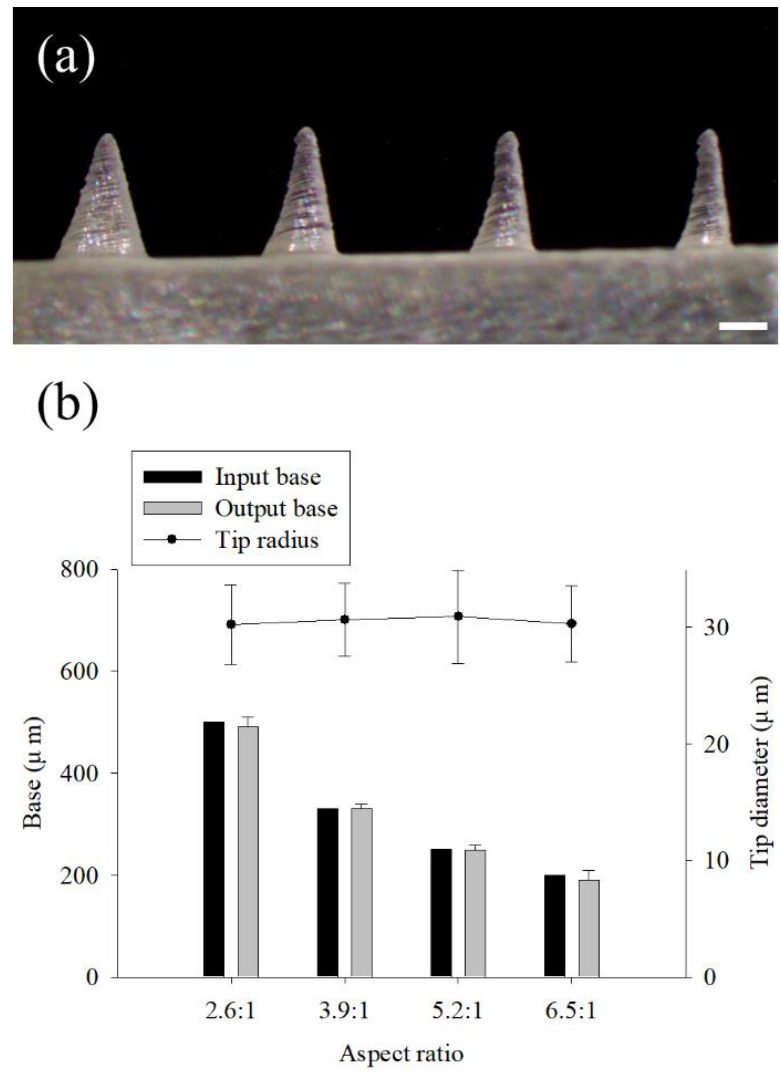
Figure 3. Effect of the aspect ratios of the microneedle on the 3D printing. Stereomicroscopic images of the microneedles with 1300 µ m input height and 500 µ m base at the aspect ratios of 2.6:1, 3.9:1, 5.2:1, and 6.5:1 ( a ). The dimensions of the input to output base and the tip diameter according to the aspect ratios ( b ) ( n = 7, scale bar is 1.0 mm).